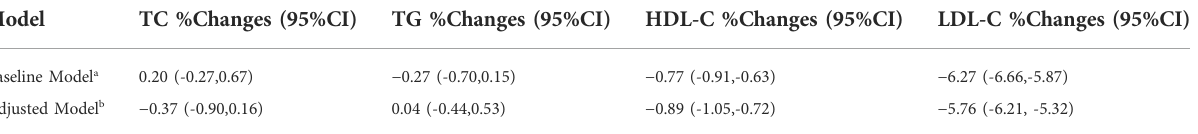
TABLE 2 Association between a 1- μ g/m 3 increment of PM 2.5 and blood